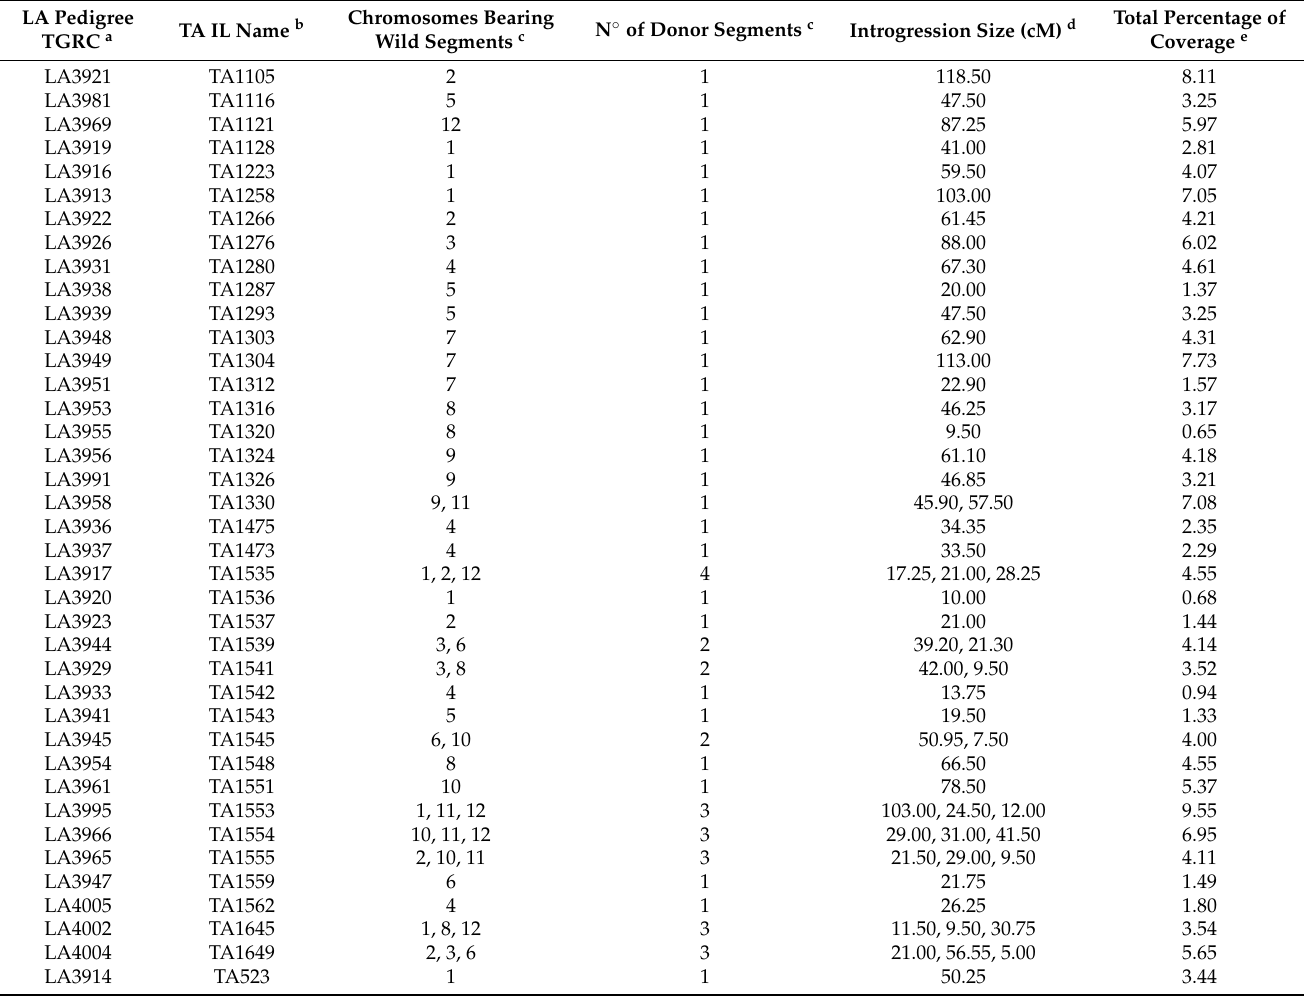
Table 1. Chromosomal location, number, size, and percentage of the coverage of the wild fragments in the Solanum habrochaites LA1777 introgression lines phenotyped in the present study. LA Pedigree TGRC